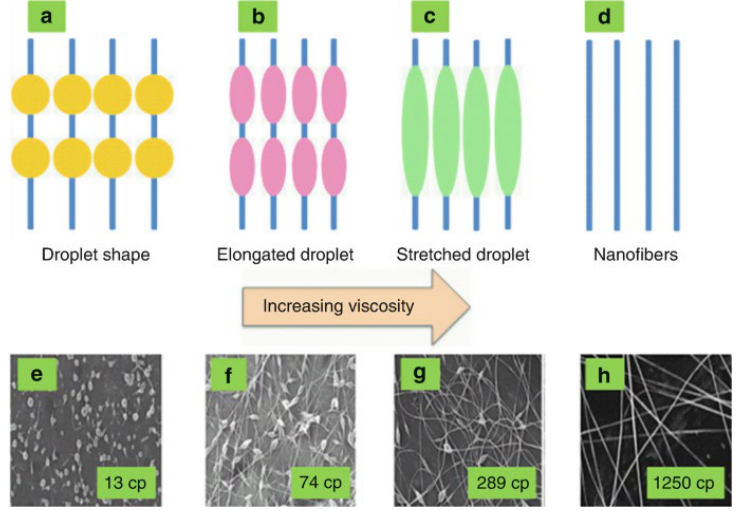
Figure 8. Modification in morphology of electrospun nanofibers of polyethylene oxide with viscosity: ( a – d ) schematic and ( e – h ) SEM micrographs. Reproduced from [92] with permission from Elsevier and Arabian Journal of Chemistry .